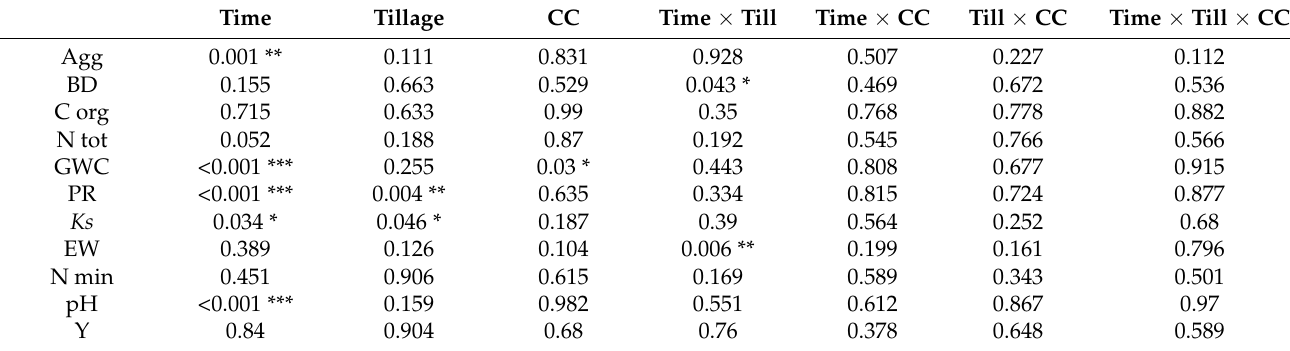
Table 2. Comparison of p -values among the linear mixed-effect model analysis of observed param- eters (Agg—aggregate stability; BD—bulk density; C org—soil organic carbon; N tot—soil